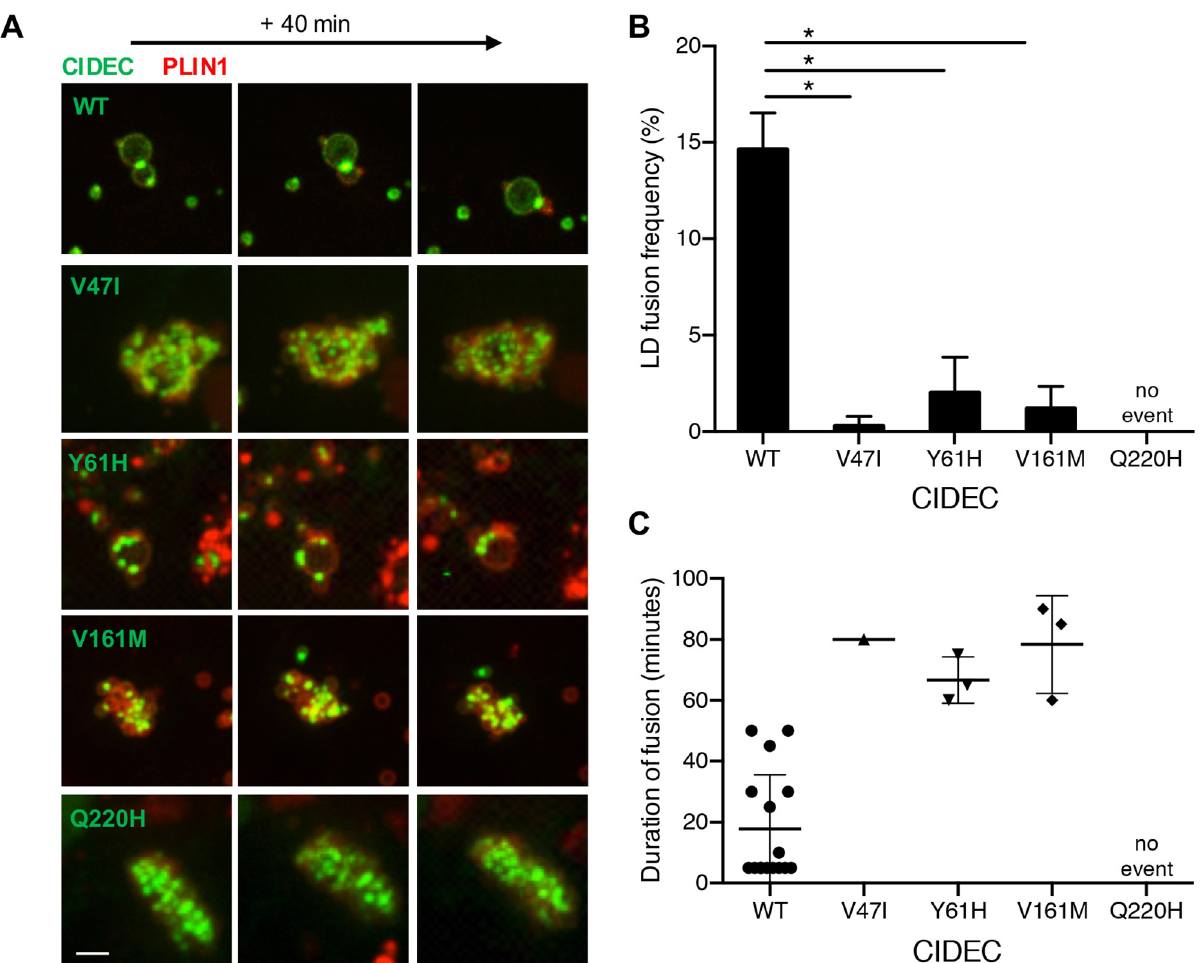
Fig 4. Lipid droplet (LD) fusion occurs less frequently and more slowly in pre-adipocytes expressing the AMD CIDEC rare variants. (A) Representative time-lapse images over 40 minutes of LDs in cells co-expressing GFP-tagged CIDEC WT (taken from S1 Video) or each of the rare variants, and mCherry-tagged PLIN1. Scale bar: 2 μ m. (B) Percentage of LDs undergoing fusion during the 6-hour analysis. N = 3 (mean ± SD, Student’s t test, * p < 0.05). (C) Time in minutes required from initial LD–LD contact to complete LD